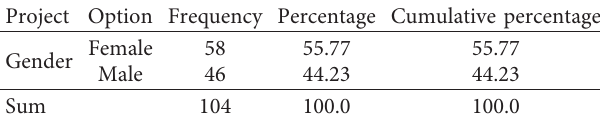
Table 1: Basic analysis ( n � 104).